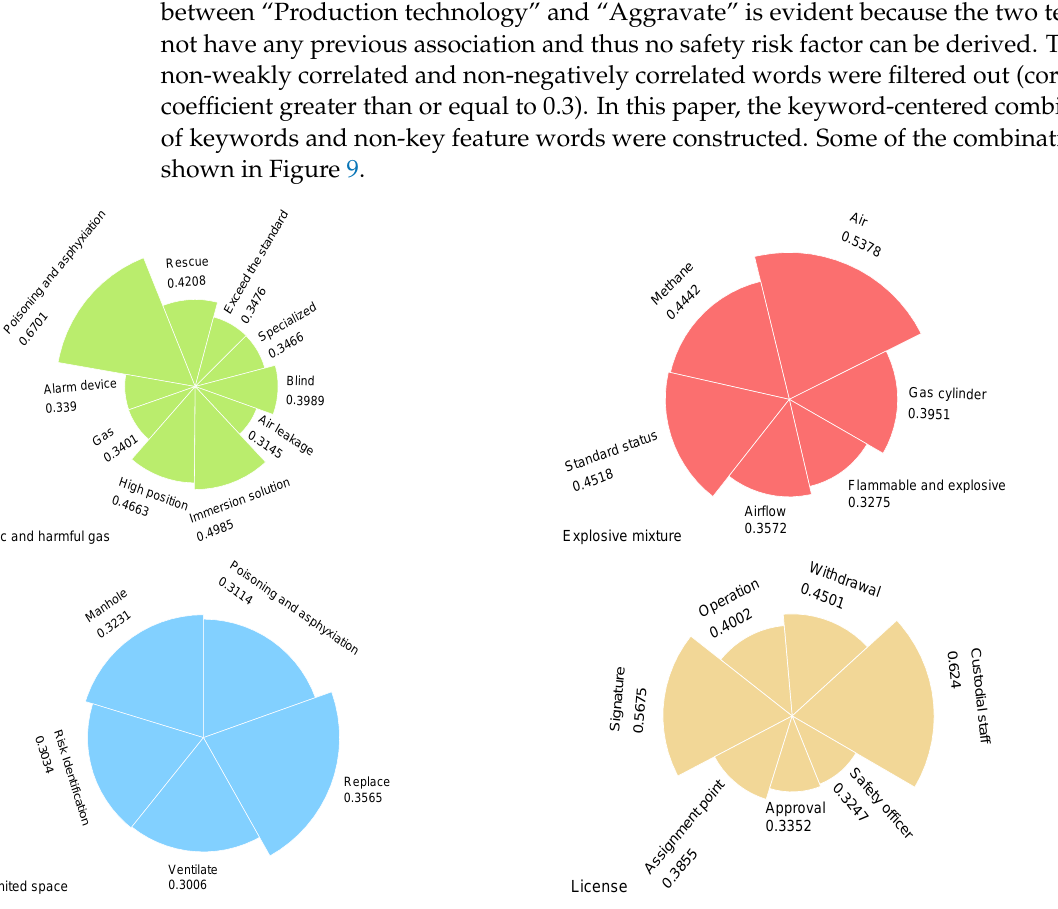
Figure 9. The combinations of keywords and non-key feature words.